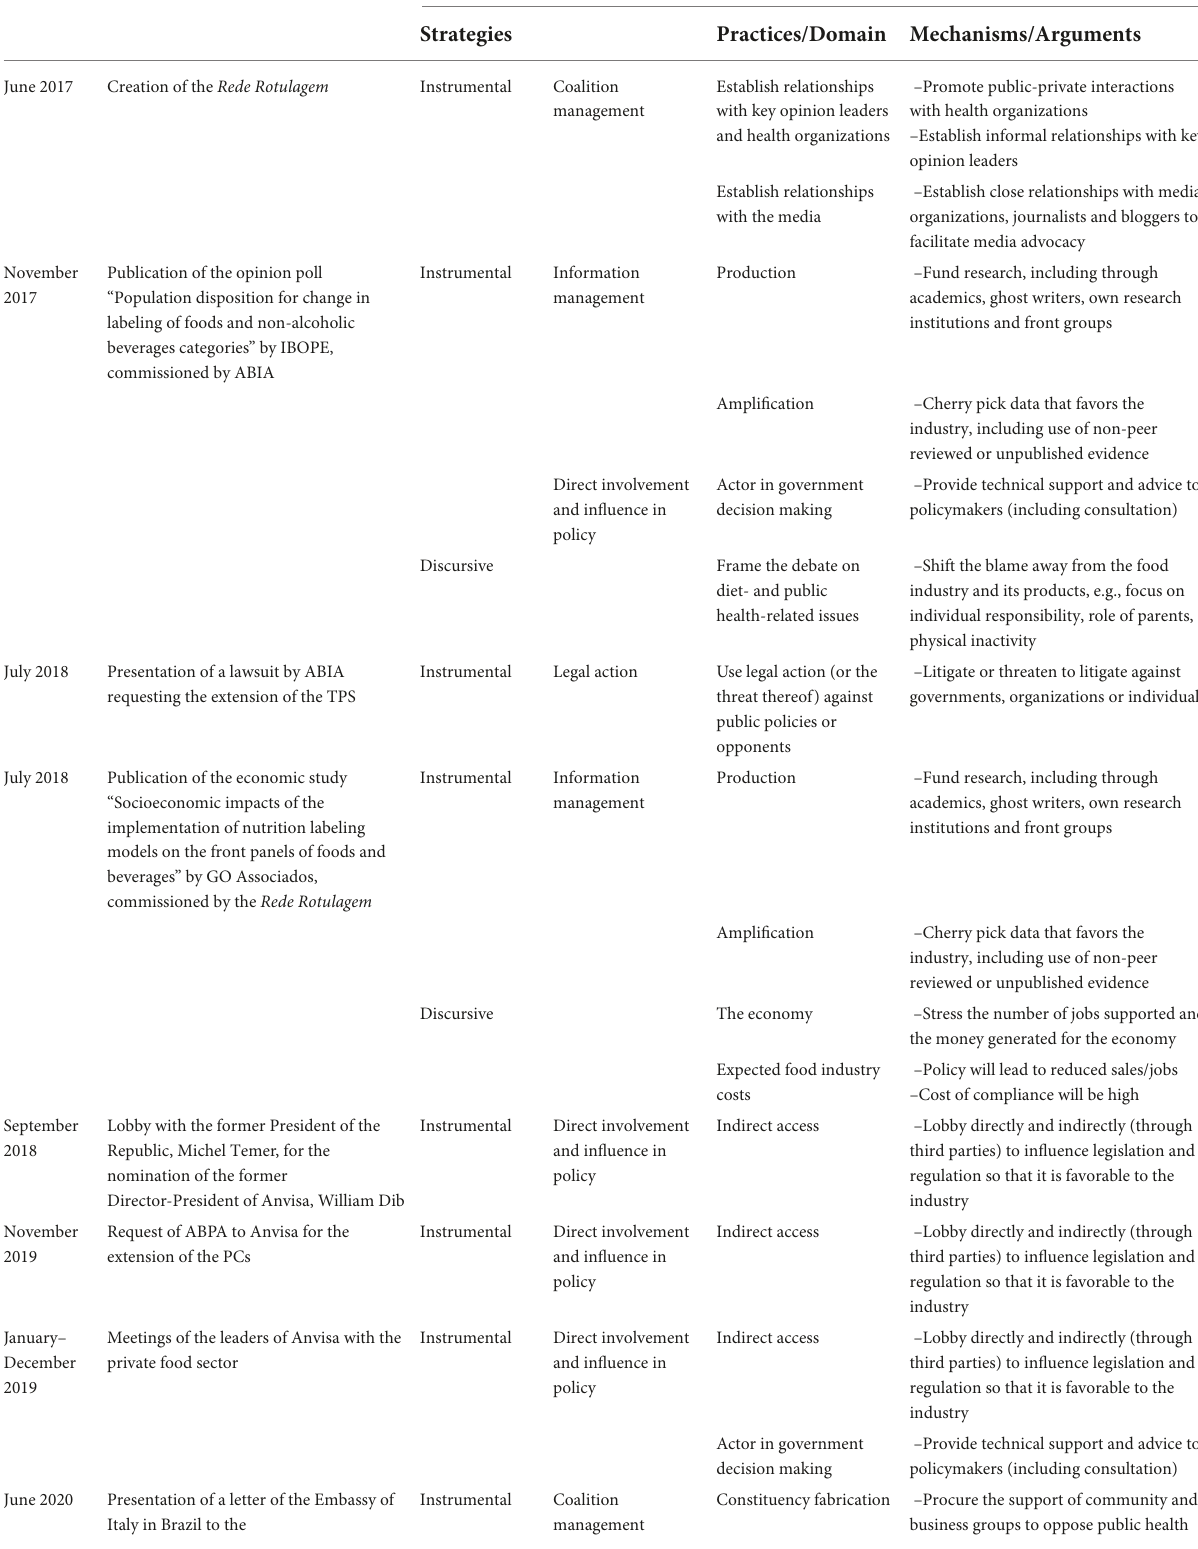
TABLE 1 Timeline and classification of the main corporate political activities and conflicts of interest situations during the regulatory process of nutrition labeling of packaged